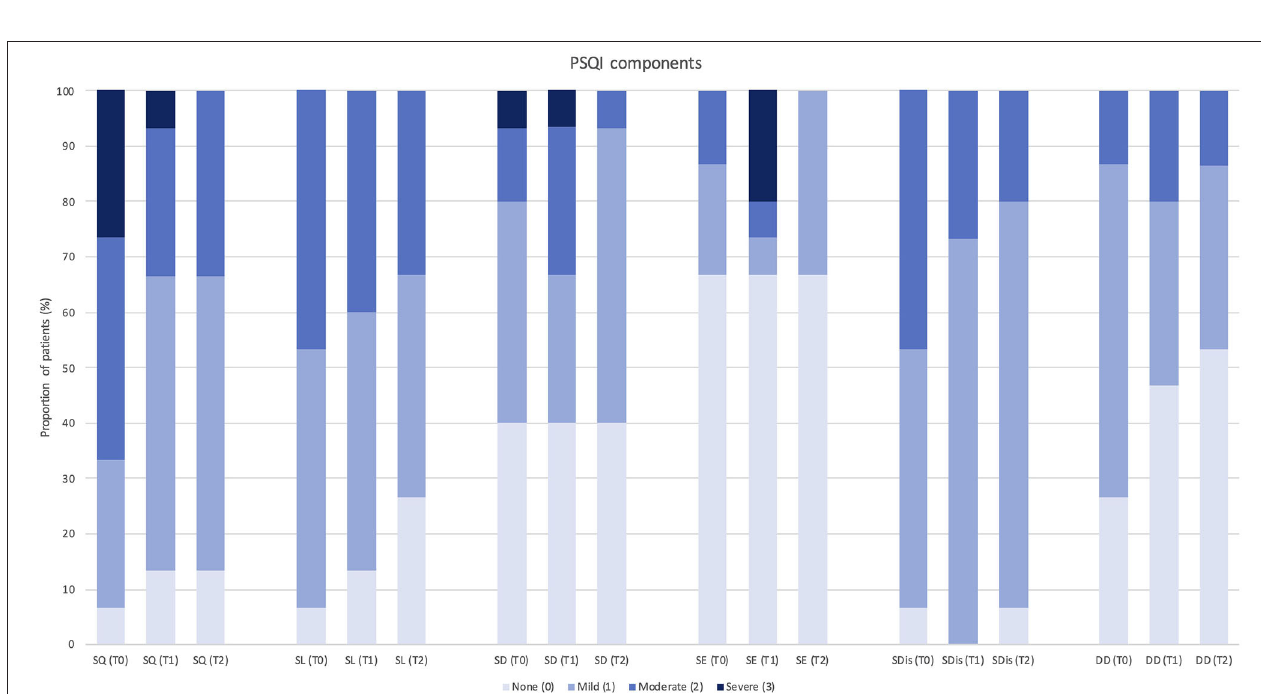
FIGURE 3 | Change in each Pittsburgh Sleep Quality Index component score after 12 months of treatment with erenumab ( n = 15). PSQI, Pittsburgh Sleep Quality Index; SQ, subjective sleep quality; SL, sleep latency; SD, sleep duration; SE, habitual sleep efficiency; SDis, sleep disturbances; DD, daytime dysfunction; T0, score at baseline; T1, score after 3 months of treatment; T2, score after 12 months of treatment.